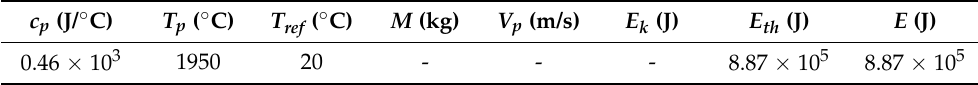
Table 7. Energy calculation of the GF process.